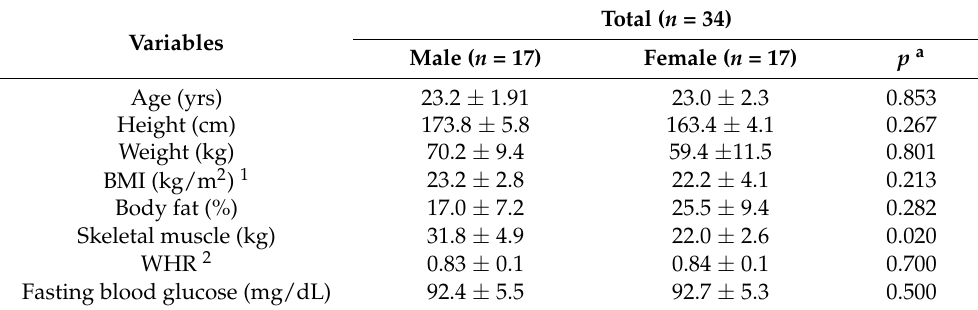
Table 2. Baseline characteristics of the